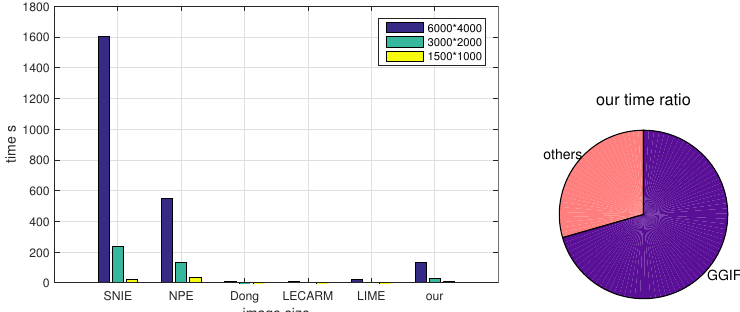
Figure 10. Comparison of the running times between six algorithms. The left shows the times of six algorithms, the right is the percentages on the running time in our